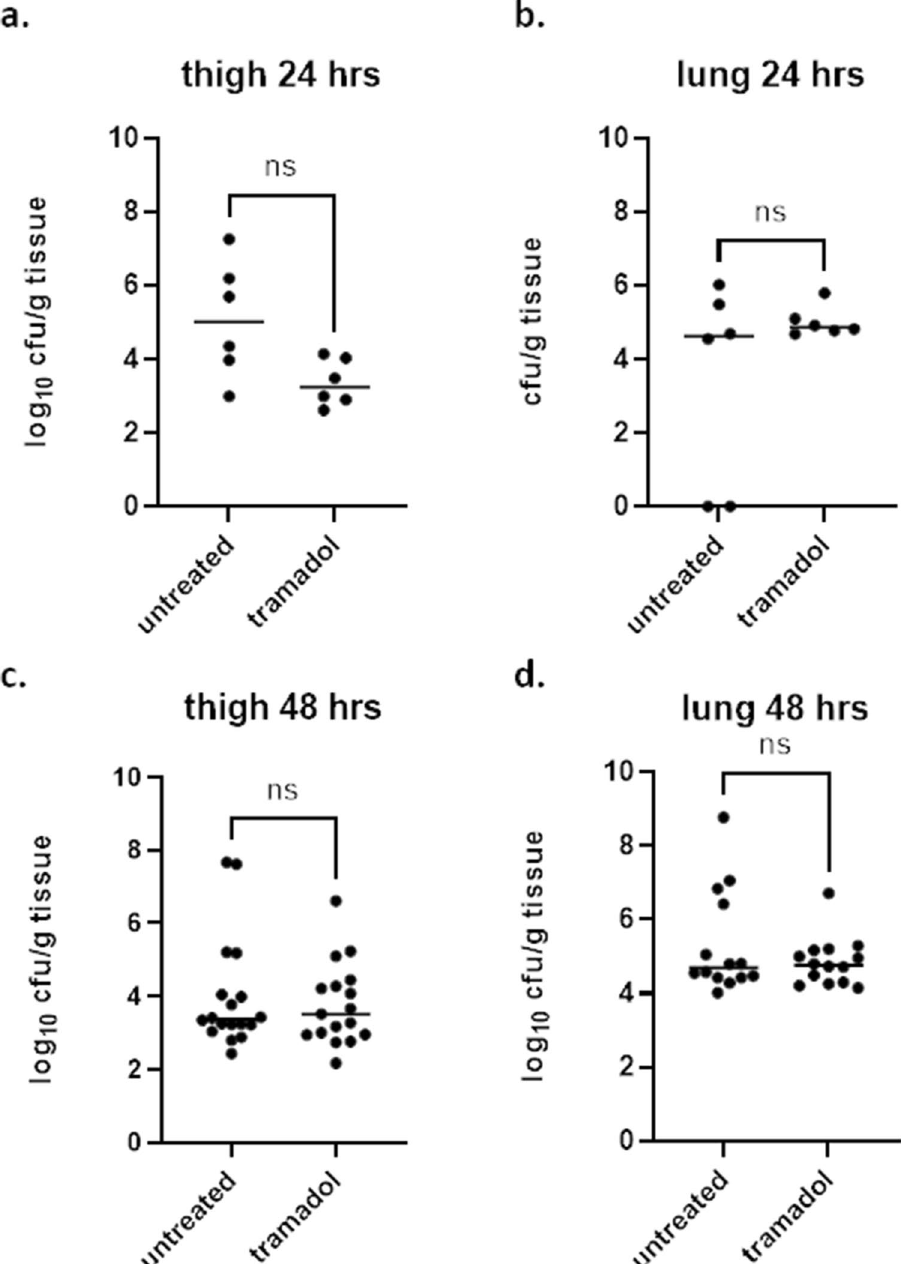
Figure 3. Bacterial burden in untreated and tramadol-treated groups in the neutropenic thigh infection model with two different readout time points of the same strain of P. aeruginosa . Bacterial burden expressed as cfu/g tissue was assessed for groups that were treated with either 20 mg/kg tramadol subcutaneously or left untreated. All groups were infected with P. aeruginosa either for 24 h (( a,b ); n = 6 per group) or for 48 h (( c,d ); n = 18 per group). Bacterial burden was assessed in thigh ( a,c ) and lung ( b,d ). Statistical testing was performed using a Kolmogorov–Smirnov test. Ns not